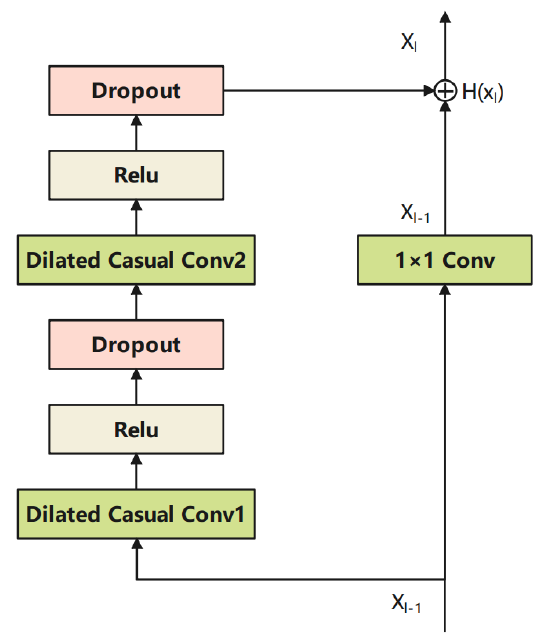
Figure 6. Illustration of the residual block.